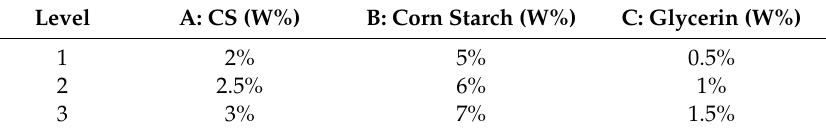
Table 1. L9 (33) orthogonal experiment with different factors and levels.